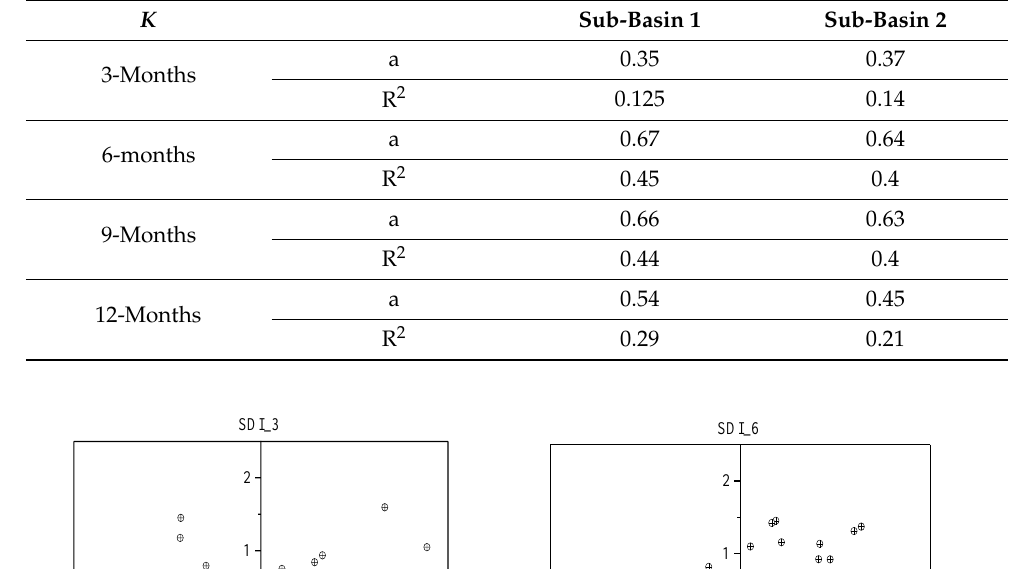
Table 1. Results of Regression modeling developed between SDI on SPI.